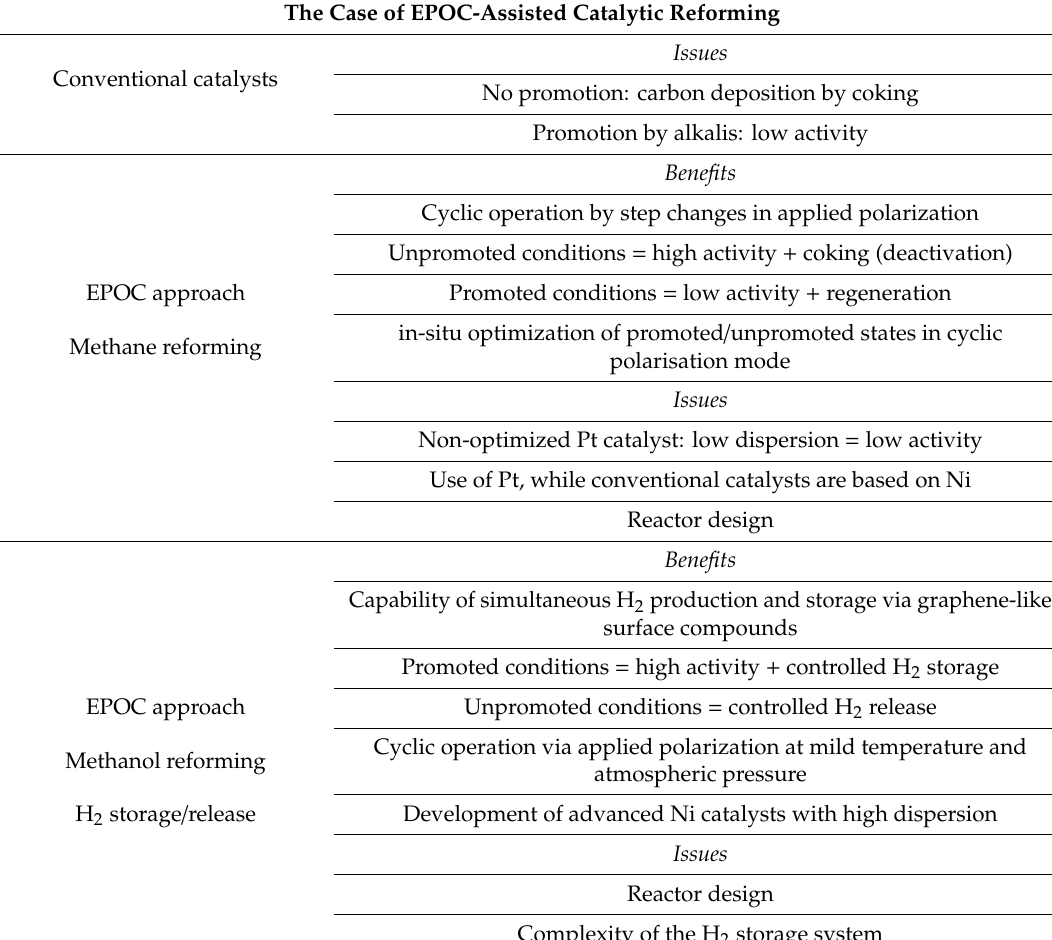
Table 3. Main issues and benefits of the EPOC-assisted methane and methanol steam